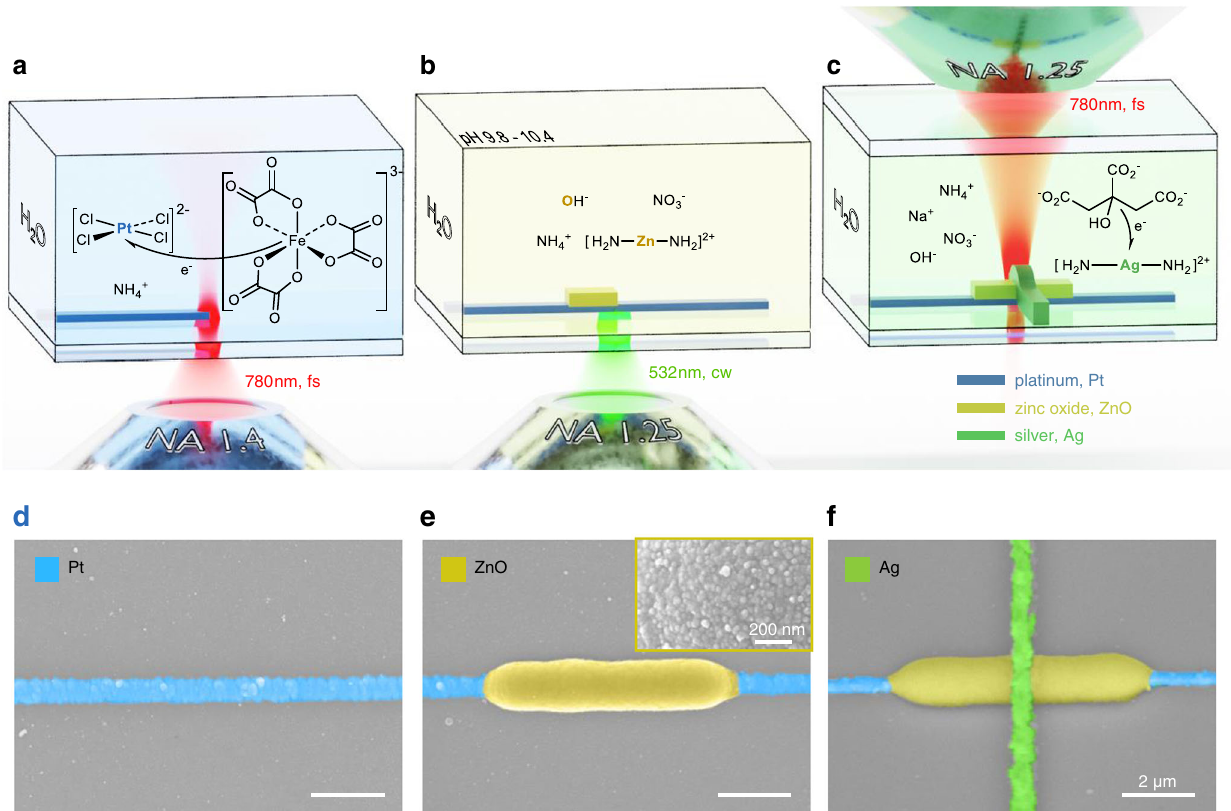
Fig. 1 | Direct laser printing of microelectronic structures. a Scheme of a fem- tosecond laser centered around 780nm wavelength that is focused into the Pt ink for multi-photon reduction of Pt. b A continuous-wave laser at 532nm wavelength is focused onto a Pt wire immersed in the ZnO ink for the local photothermal synthesis of ZnO. c The 780nm femtosecond laser is focused above the ZnO layer